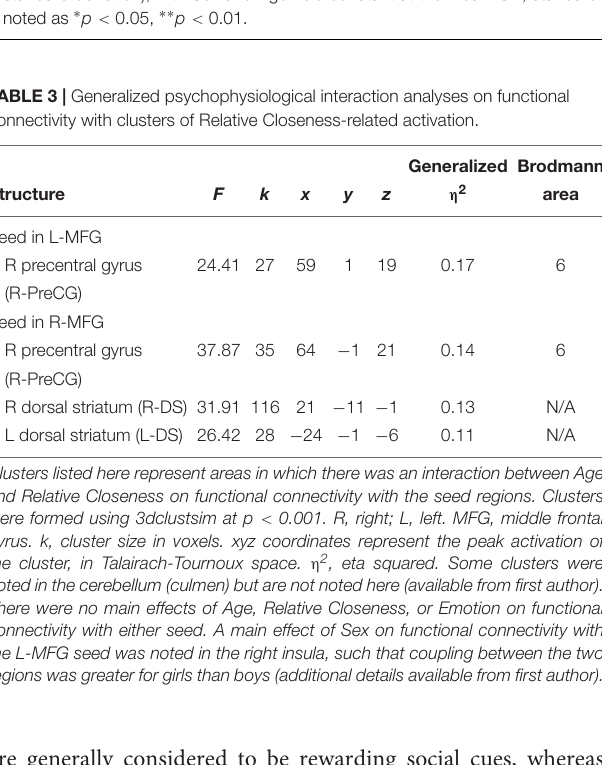
FIGURE 5 | Interaction between participants’ relative closeness and facial emotion type on neural activation during stimulus presentation. R, right; TPJ, temporal-parietal junction. Cluster was formed using 3dclustsim at p < 0.001, with a cluster size threshold of 27 voxels. Brain image is rendered in the Talairach-Tournoux template space. Refer to Table 2 for description of region of activation. Plotted activation in the line graph is estimated from marginal means for activation by emotion type at low levels of Relative Closeness (–1 standard deviation), mean levels of Relative Closeness, and high levels of Relative Closeness ( + 1 standard deviation), with Sex and Age held constant at the mean. SD, standard deviation. The significance of the slope for different emotions (i.e., slope (cid:54)= 0) is noted as ∗ p < 0.05, ∗∗ p < 0.01.